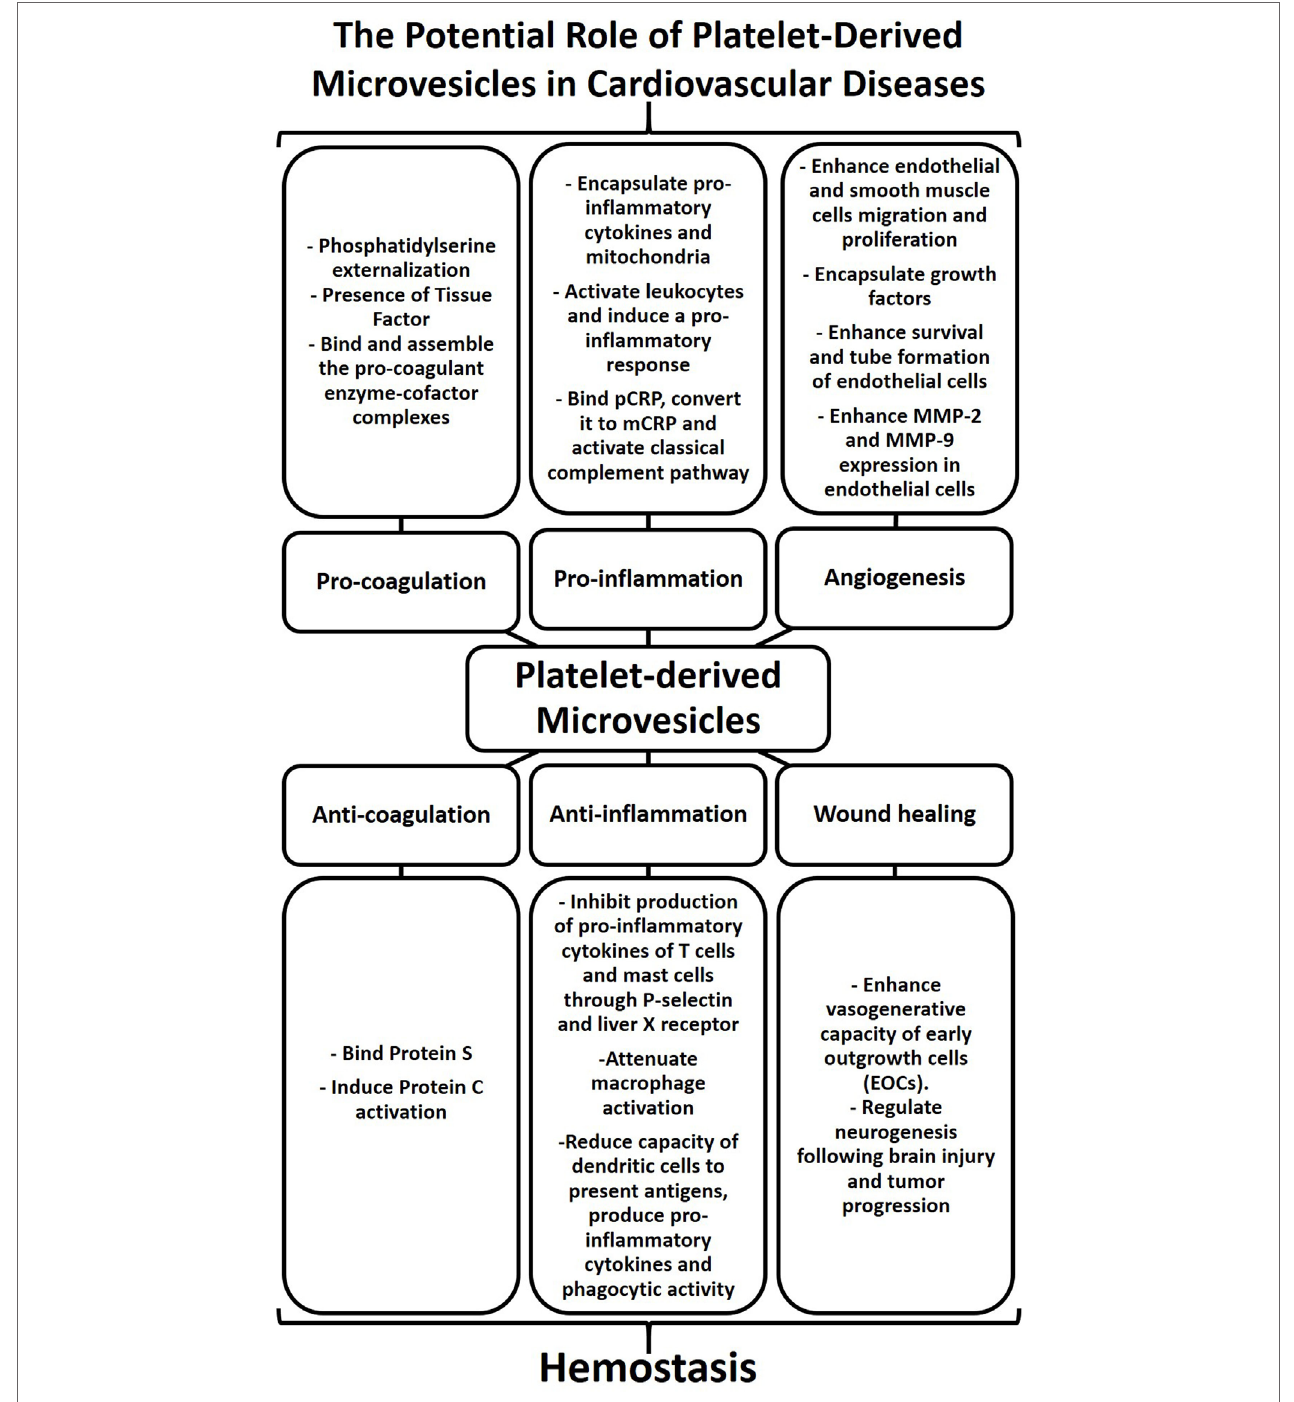
FiGURe 2 | Platelet-derived microvesicles (PMVs) as regulators of hemostasis and contributors to cardiovascular diseases. The physical characteristics of the cell membrane and biological cargo define the biological role of PMVs. PMVs bind natural anticoagulants thereby preventing coagulation. PMVs can also inhibit cytokine production leading to a reduction of vascular inflammation. In addition, PMVs can enhance the vasogenerative capacity of cells, thus highlighting their role in wound healing. While PMVs play a major role in regulating hemostasis, excessive numbers of PMVs can also contribute to cardiovascular diseases. The presence of phosphatidylserine and tissue factor in PMVs can induce procoagulant enzyme–cofactor complexes that favor thrombosis. PMVs can also induce cytokine production, bind protein C-reactive protein (pCRP), and convert it to monomer of C-reactive protein (mCRP), thereby promoting inflammatory responses. The activation of smooth muscle cells, endothelial cells, and leukocytes by PMVs as well as growth factors encapsulated within PMVs can stimulate angiogenesis. Therefore, PMVs may stimulate or dampen coagulation, inflammation, and angiogenesis and may thereby contribute to cardiovascular